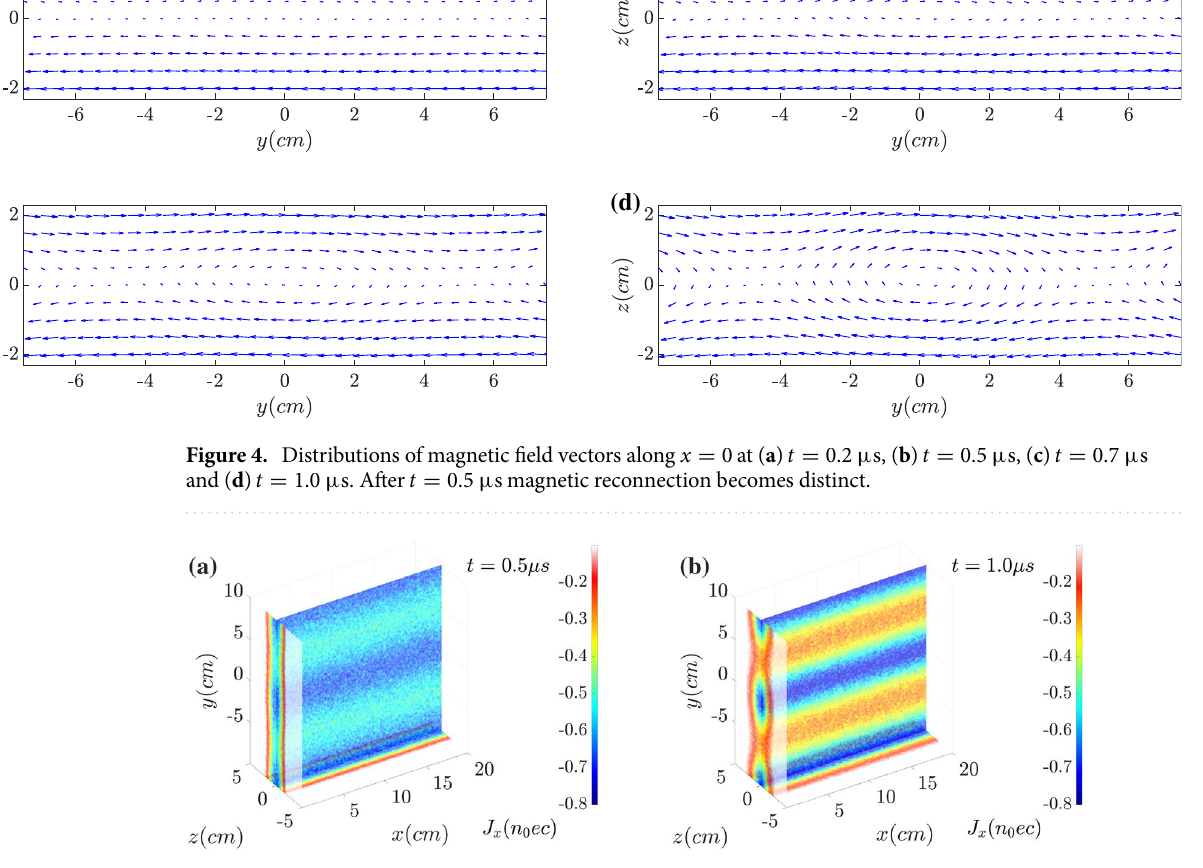
Figure 5. Distributions of current near the electron current sheet J x at ( a ) t = 0.5 µ s and ( b ) t = 1.0 µ s . The net current shows the filamentation along with magnetic